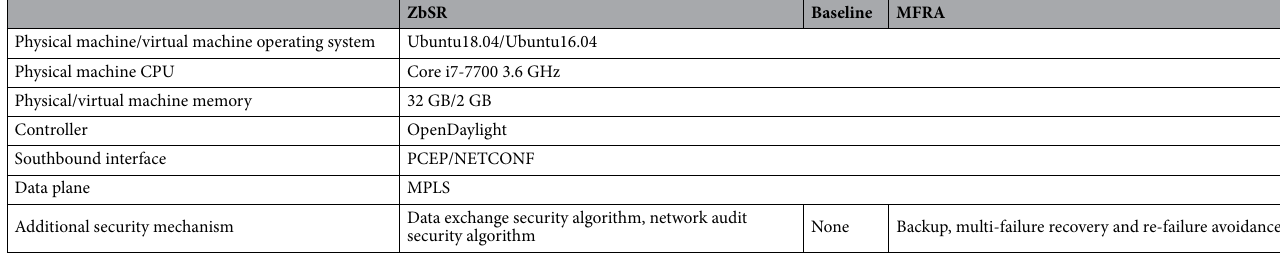
Table 8. Test object